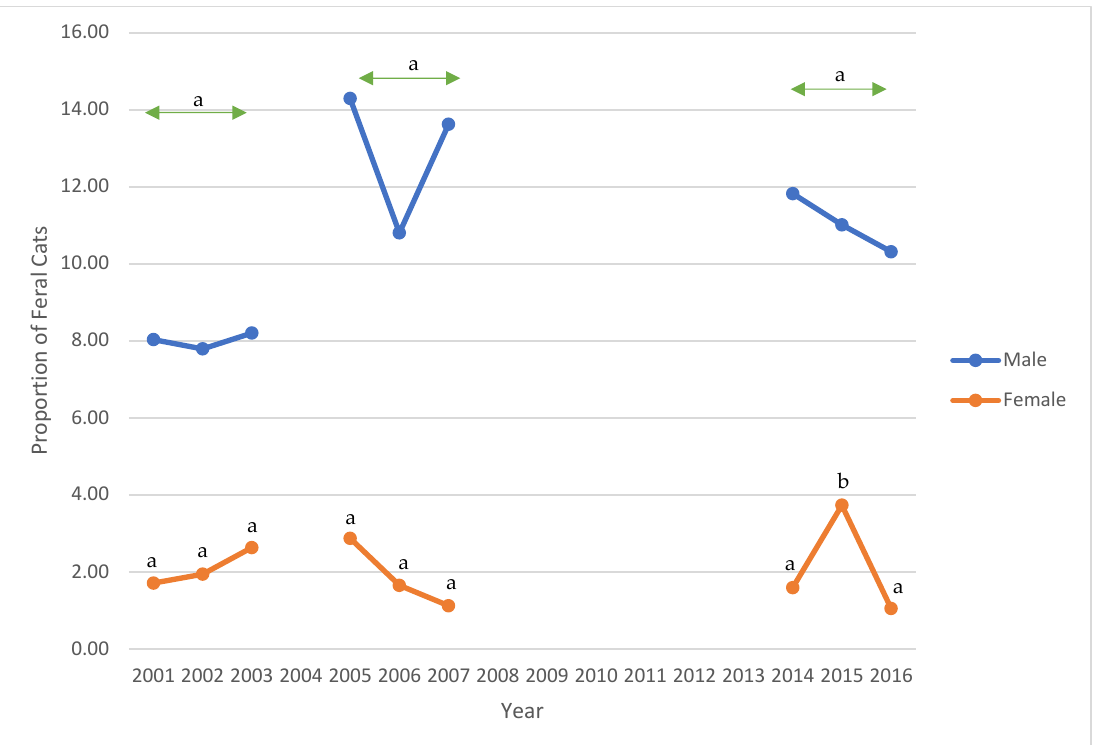
Figure 3. Prevalence of feline leukemia virus ‐ positive feral cats, stratified by sex, presented to the PHS Spay/Neuter Clinic, 2001–2003, 2005–2007, and 2014–2016. Notes: a— p = 0.02; b— p = 0.04 across the period.